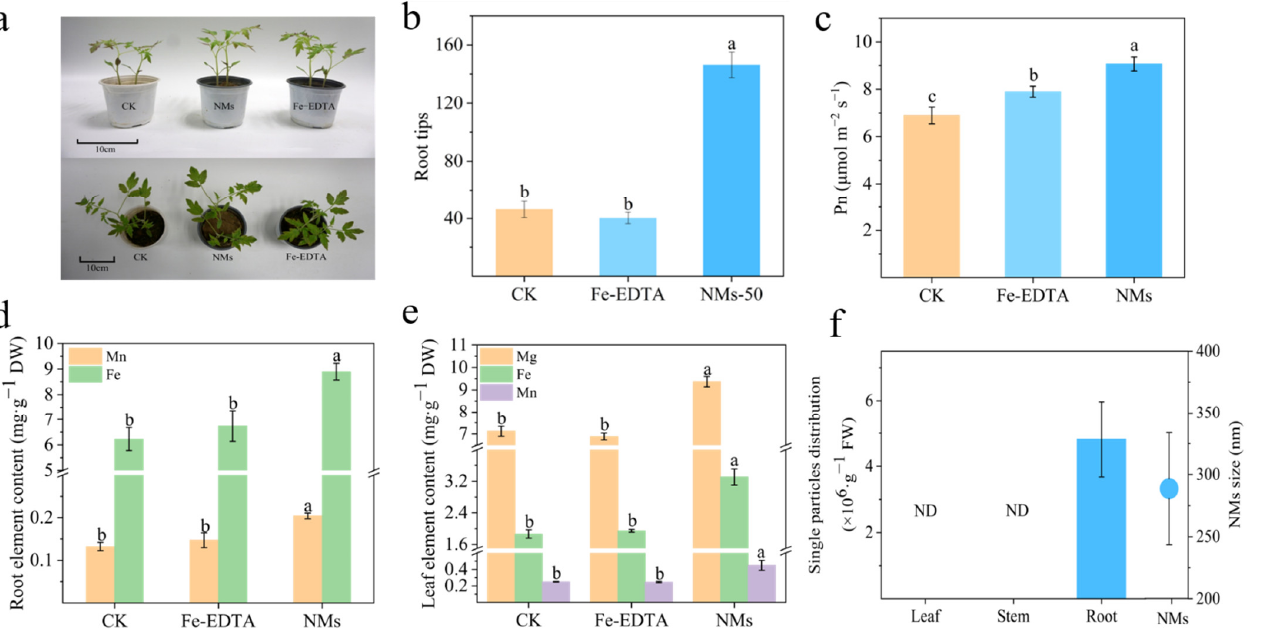
Figure 3. The impacts of Fe 7 (PO 4 ) 6 NMs on tomato seedling growth. ( a ) tomato phenotype; ( b ) root tips number; ( c ) Pn of the fourth fully unfolded true leaf; ( d , e ) element content of significant increased by NMs treatment in roots and shoots; ( f ) single particles distribution in leaf, stem and root of Fe 7 (PO 4 ) 6 NMs and average size of NMs. Different letters in ( b – e ) represent significance of p < 0.05. ND in ( f ) means not detected.